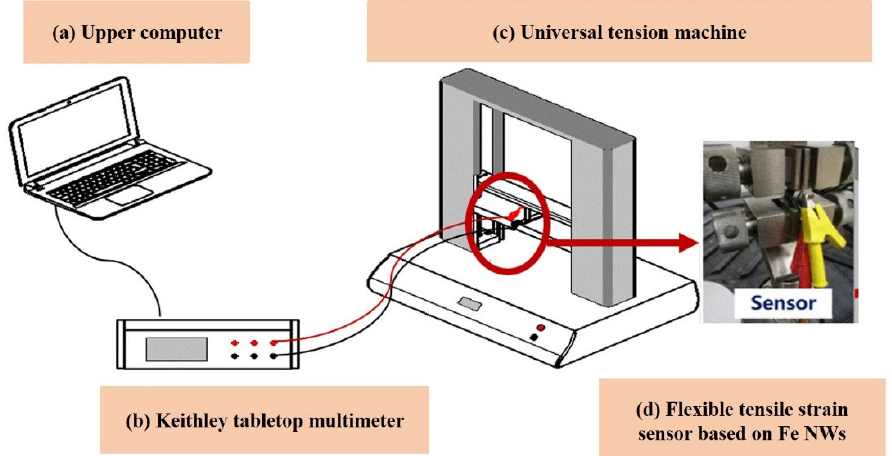
Figure 4. Experimental construction and mechanical performance analysis of a flexible tensile strain sensor based on Fe NWs: ( a ) display device, ( b ) collection device, ( c ) strain tensile test, and ( d ) flexible tensile strain sensor based on Fe NWs.